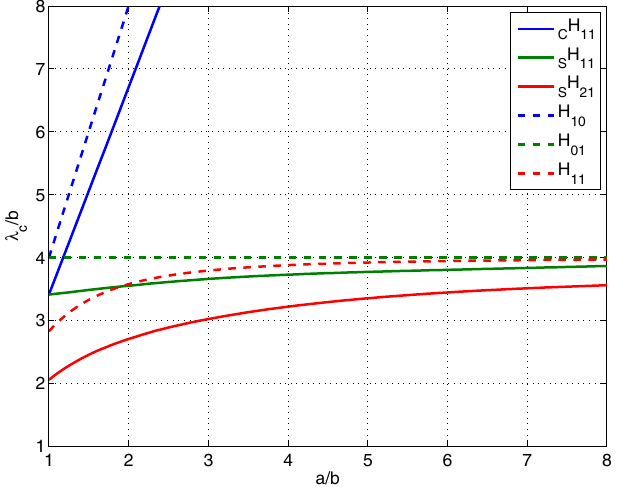
FIG. 9. (Color) Cutoff wavelengths for the three lowest H- modes in elliptical (solid line) and rectangular (dashed line) waveguides. a and b are half-width and half-height in both